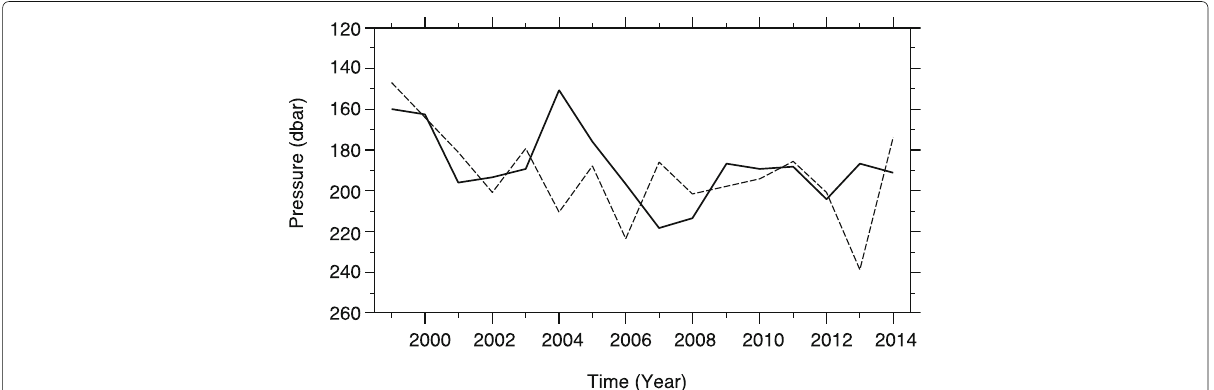
Fig. 19 Annual mean variations in the upper main pycnocline depth forced by variations in the wind stress (solid line) and the in situ halocline depth (dashed line) at station K2. The main pycnocline depth is indicated by the pressure level of the potential density of 26.8 σ θ and the halocline depth is the pressure level of the isohaline (33.8) estimated from the ship-board CTD and Argo data by Wakita et al.